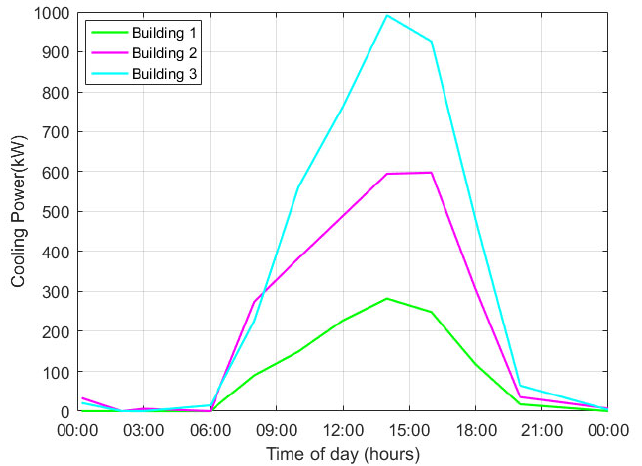
Figure 11. Total cooling power of each building of the microgrid (optimization level 1).